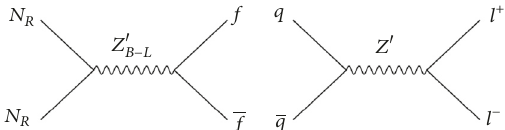
Figure 1: Left: Majorana neutrino dark matter ( 𝑁 푅 ) pair annihila- tion process into the SM fermions ( 𝑓 ) through the 𝑍 耠 퐵−퐿 exchange in the 𝑠 -channel, 𝑁 푅 𝑁 푅 󳨀→ 𝑍 耠 퐵−퐿 󳨀→ 𝑓𝑓 . Right: parton level process (quark ( 𝑞 ) and antiquark ( 𝑞 ) annihilation process) to produce a dilepton final state ( 𝑙 + 𝑙 − ) through a 𝑍 耠 exchange in the 𝑠 -channel at the LHC.